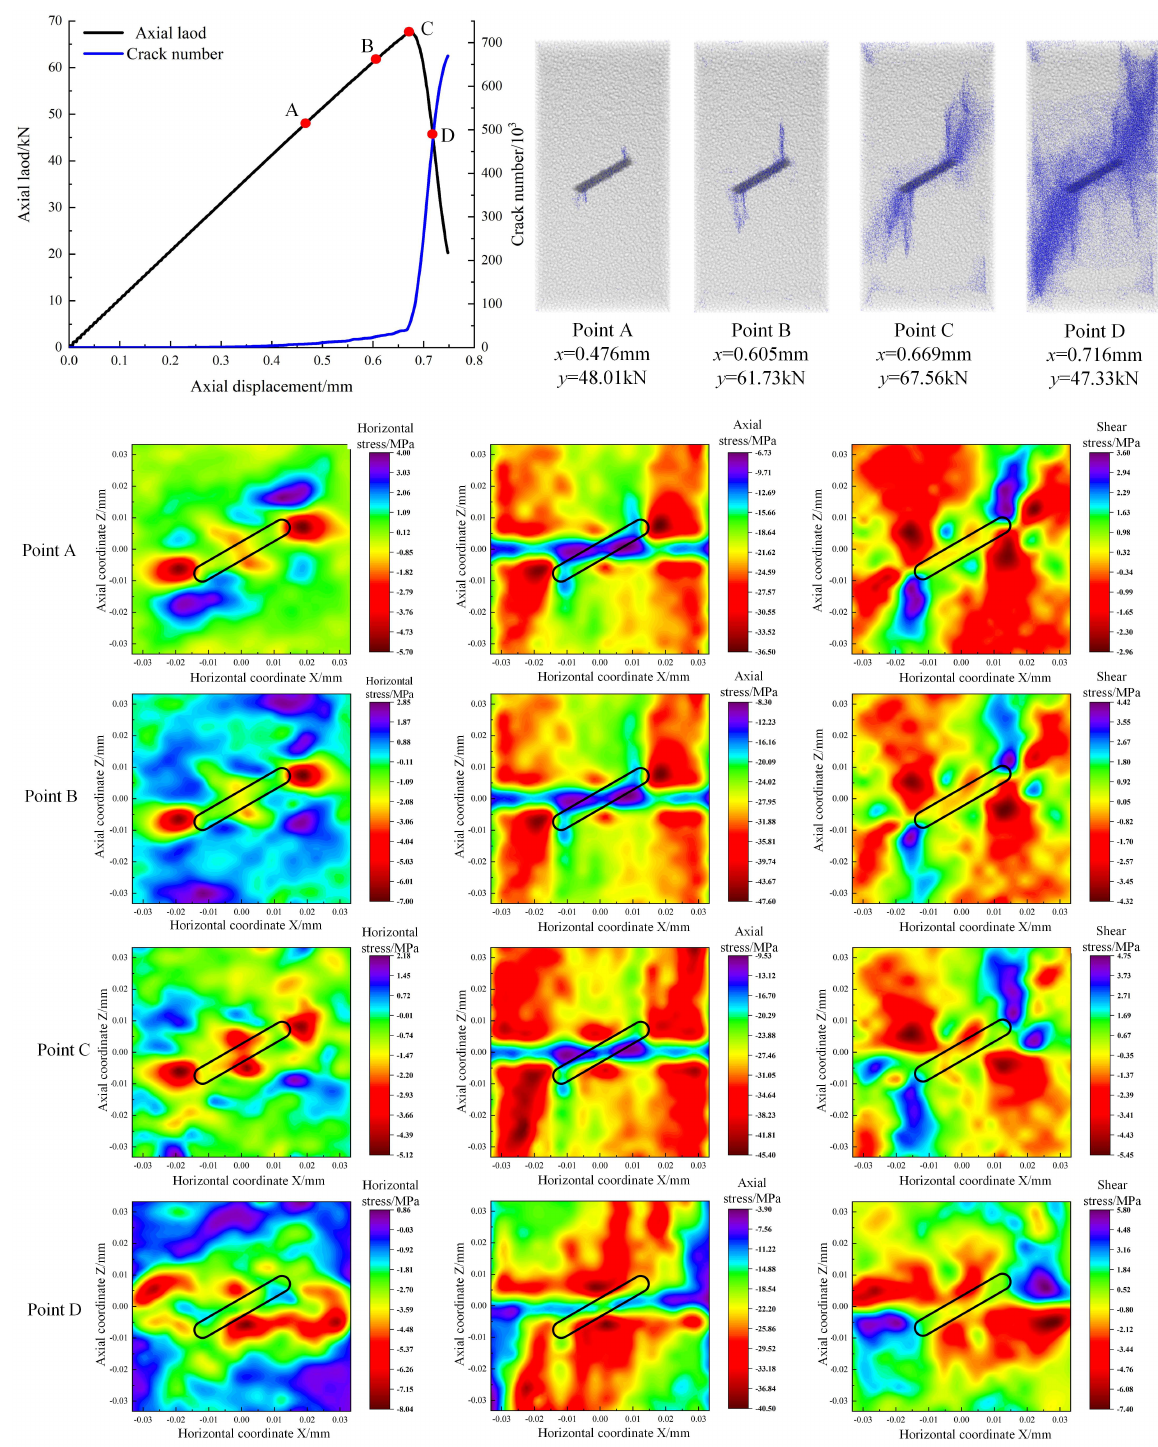
Figure 18. Crack propagation and stress evolution of F−30 sample.